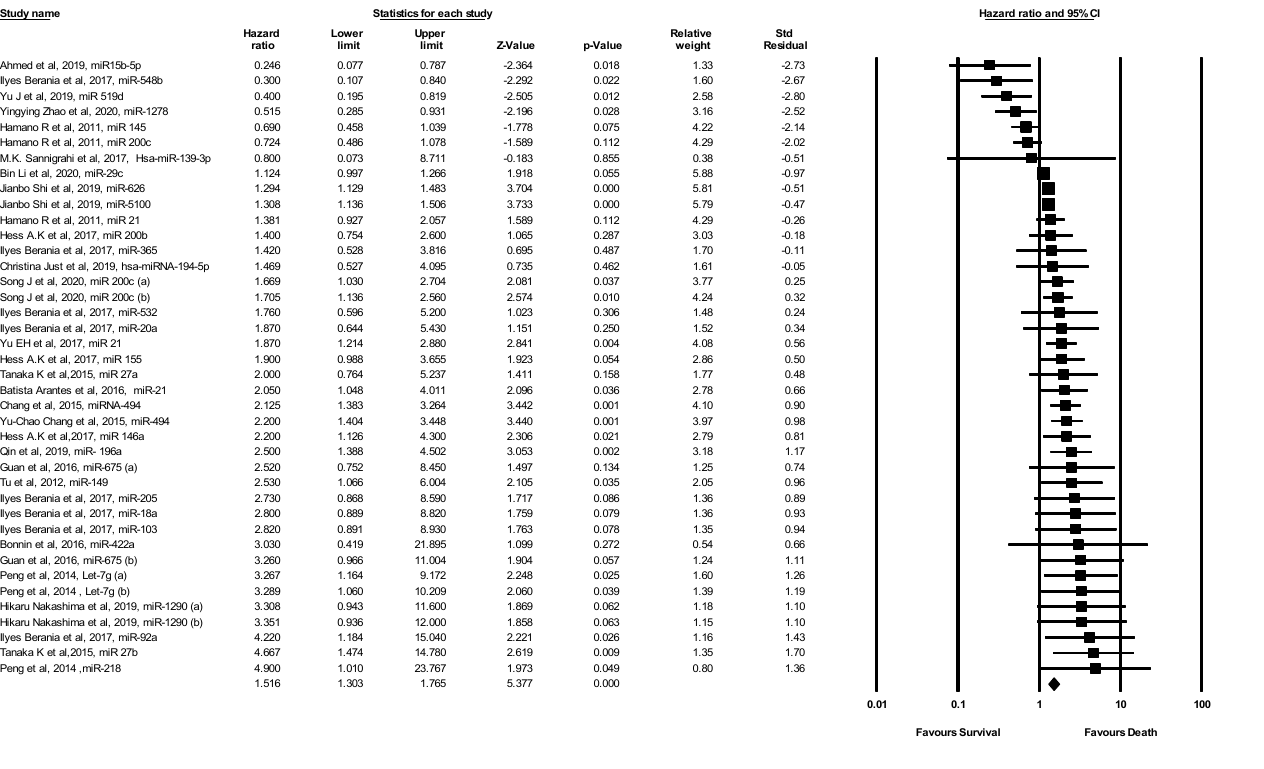
Figure 6. Forest plot of the studies included in this comprehensive meta-analysis of miRNA-specific chemoresistance in head and neck cancer.